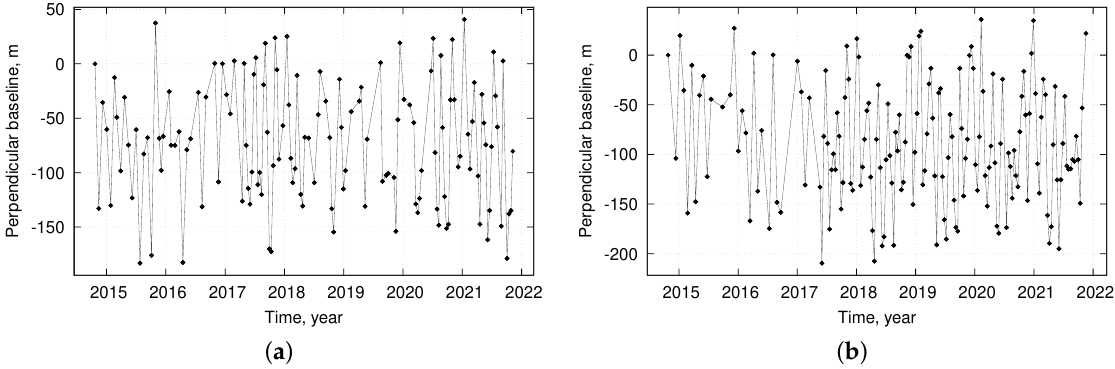
Figure 2. Spatial and temporal baselines of Sentinel-1 ascending track 065 ( a ) and descending track 131 pairs ( b ) used in this study. Mean temporal resolution, i.e., mean temporal spacing between consecutive SAR acquisitions regardless of orbit direction, computed as duration divided by number of SAR images minus one is about 9 days. Note that offset between perpendicular baselines of ascending and descending sets depends on selection of reference images, which is arbitrary.